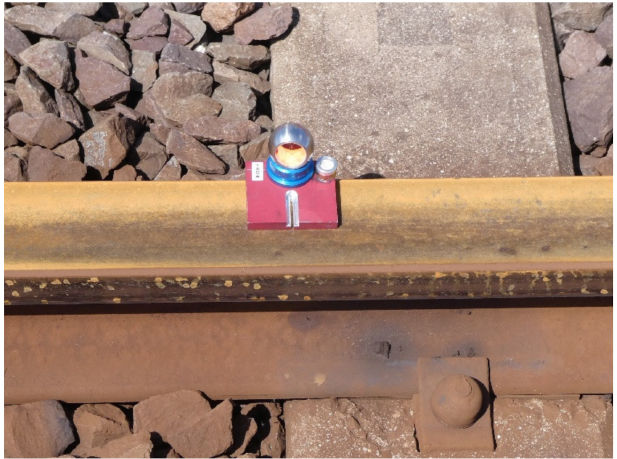
Figure 4. Rail shoe measurements of the